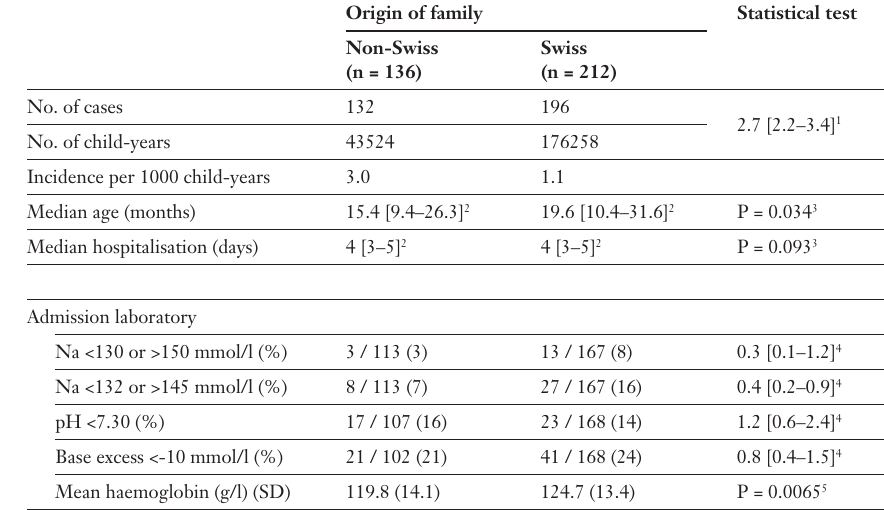
Clinical characteris- tics of RV hospitalisa- tions.